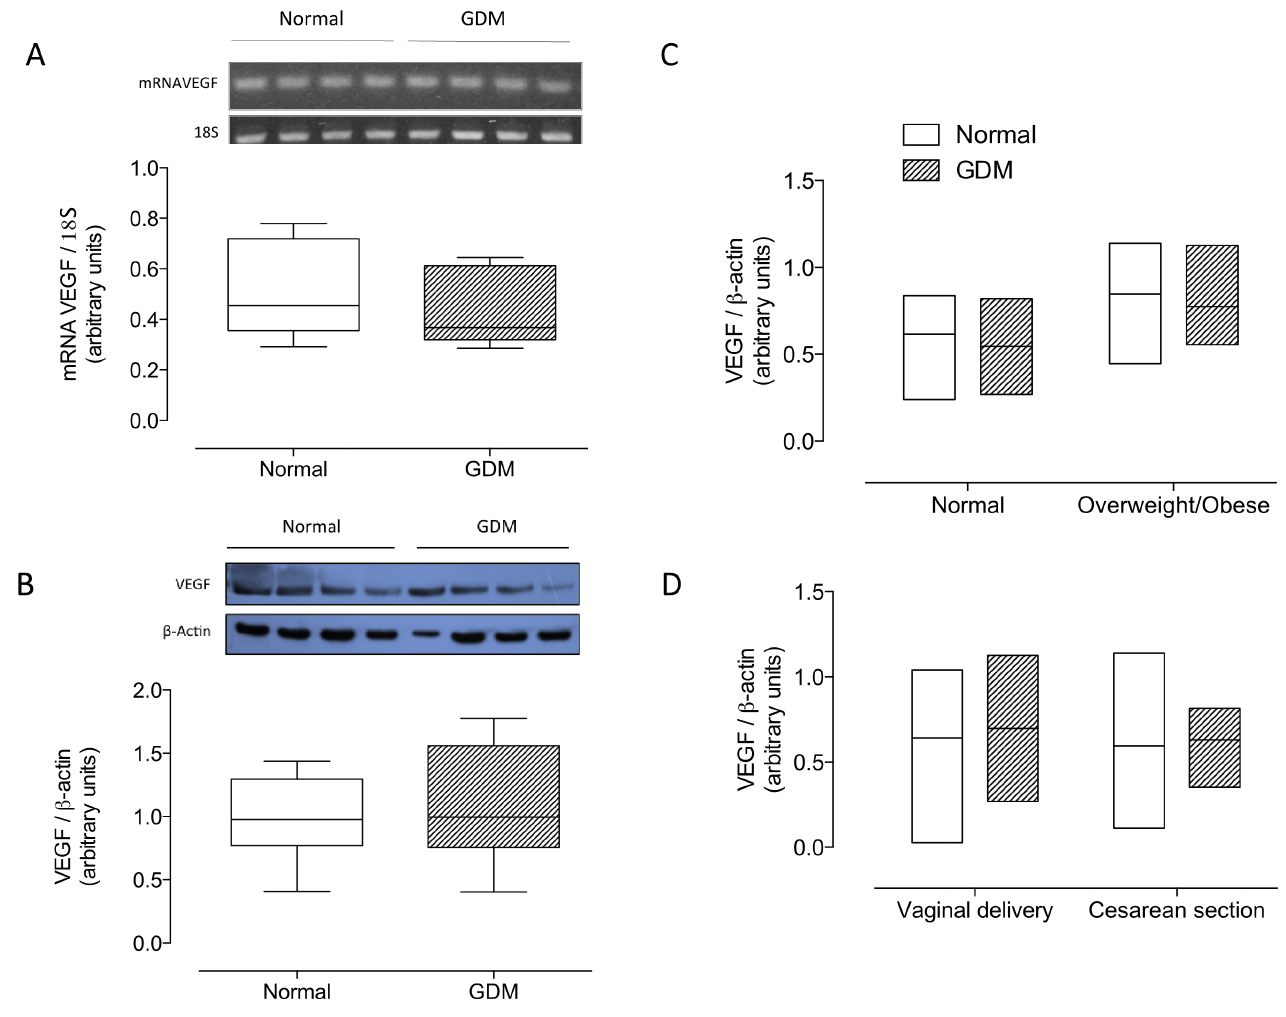
Fig 2. Placental VEGF. A) mRNA levels for VEGF in total placentalhomogenate from normal pregnancies (Normal, white bar) or gestational diabetesmellitus (GDM, hatchedbar). Values are expressedas ratio mRNAVEGF/18S obtainedby densitometric analysis. B) Western blot of VEGF (55 kDa) and β -actin (43 kDa). The bottom panel shows the results of densitometric scanningexpressedas VEGF/ β -actin ratio. C) Post-hoc analysisof VEGF protein levels as presented in B consideringmaternalbody mass index (BMI) in the first trimester D) or delivery mode. In A, n = 8 in each group. B, n = 14–15 in each